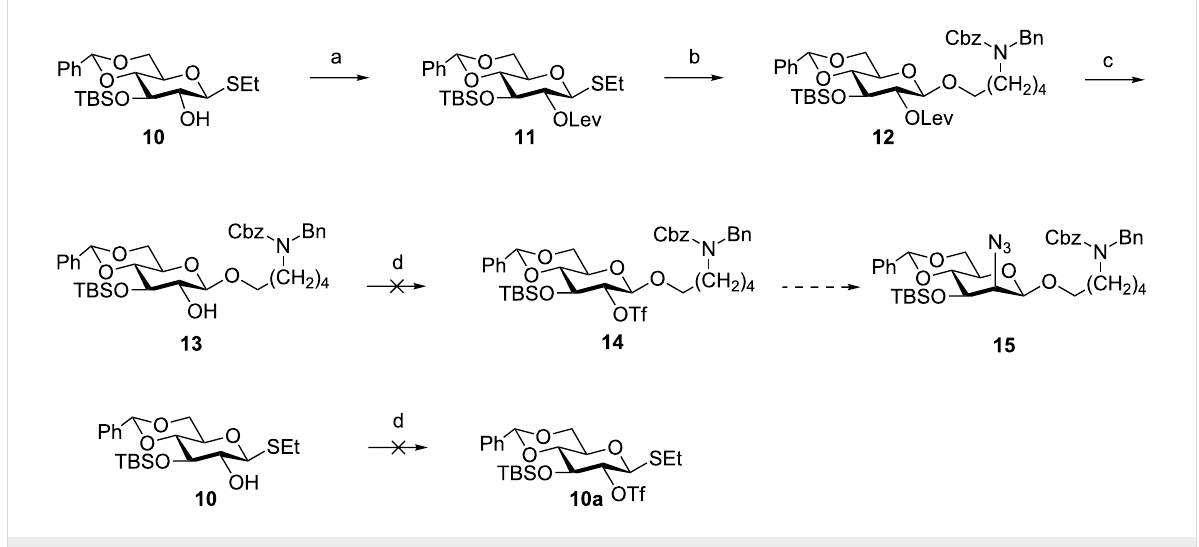
Scheme 2: Attempted synthesis of mannosazide building block 15 . Reagents and conditions: (a) levulinic acid, DCC, DMAP, CH 2 Cl 2 , 82%; (b) NIS, TfOH, HO(CH